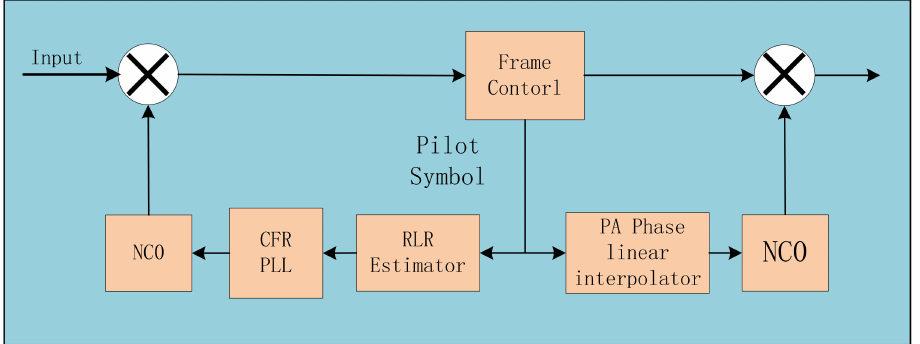
Figure 3. Proposed carrier synchronization